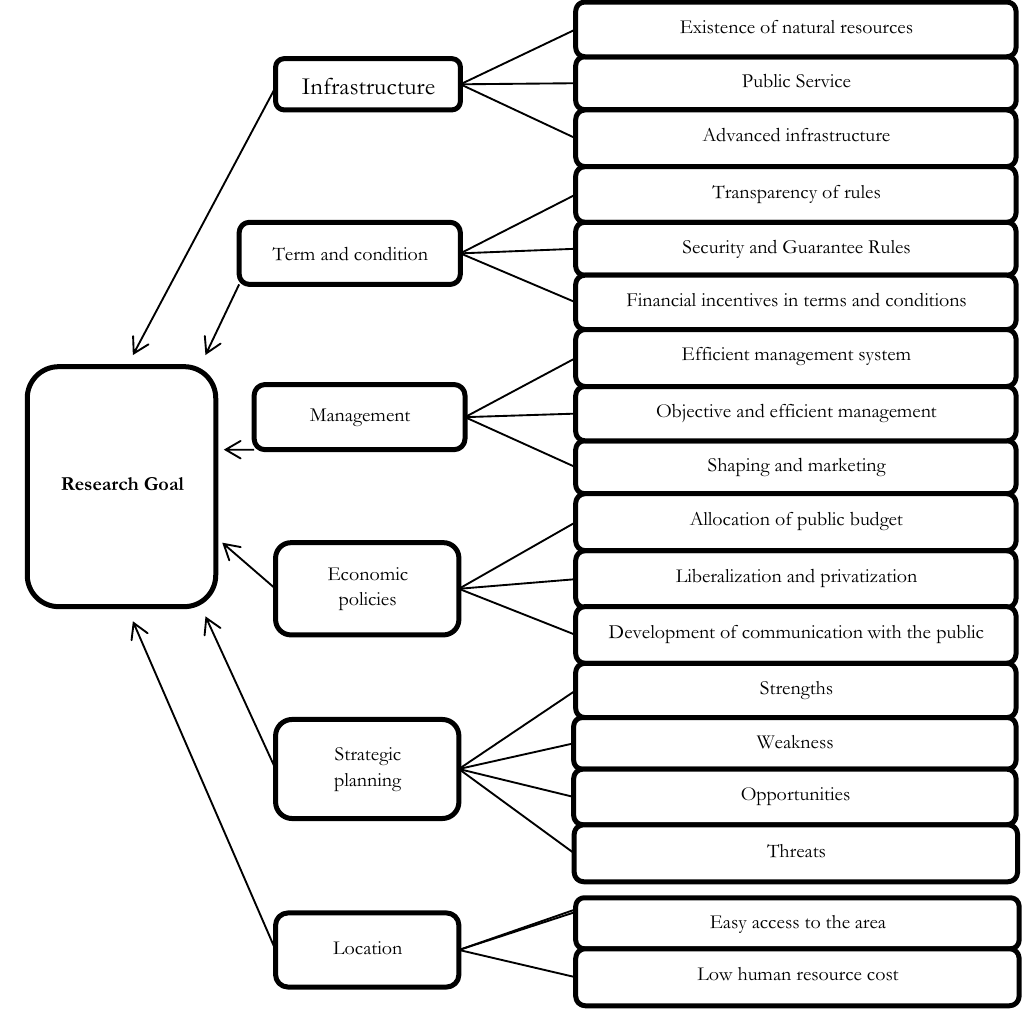
Fig. 1. The Proposed conceptual model.